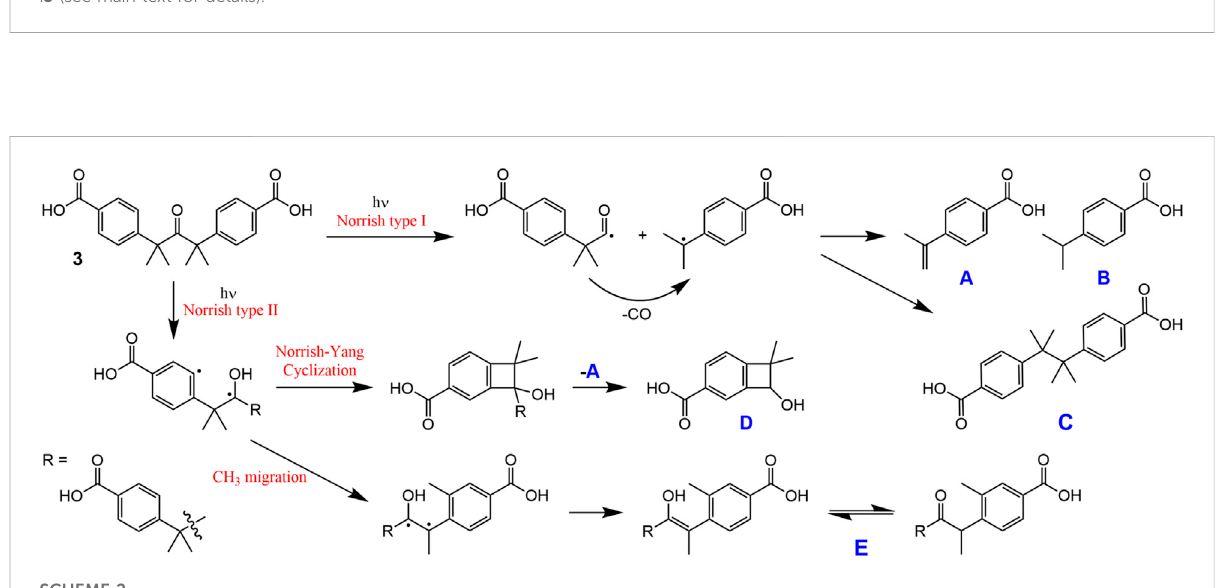
SCHEME 2 Possible photoproducts of 3 in